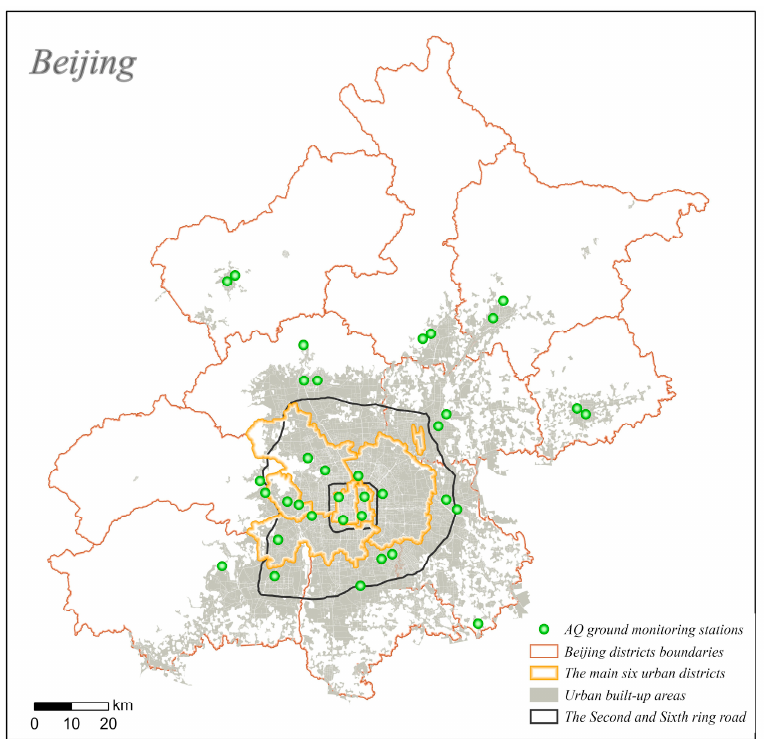
Figure 1. Map of study area, overlay with Air Quality (AQ) ground-station distributions (the green points). The built-up areas from [24] represent the urban extent in general; the ring roads witnessed the development and expansion of the city, which can help with understanding the urban, suburban, and rural areas of the city. In particular, the areas within the second ring road are the historic urban centers, while the sixth ring road is currently the outermost ring road.